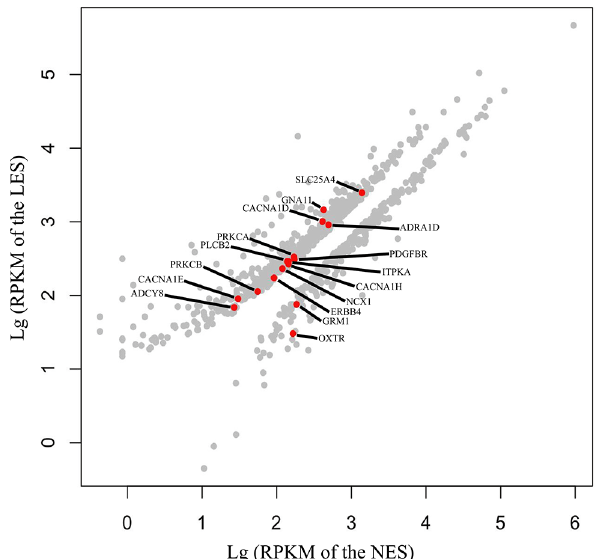
Fig 3. Differentially expressed genes (DEGs) between the low eggshell strength (LES) group and the normal eggshell strength (NES) group. The red spots represent DEGs belonging to a calcium signaling pathway (KO: 04020) ( P <